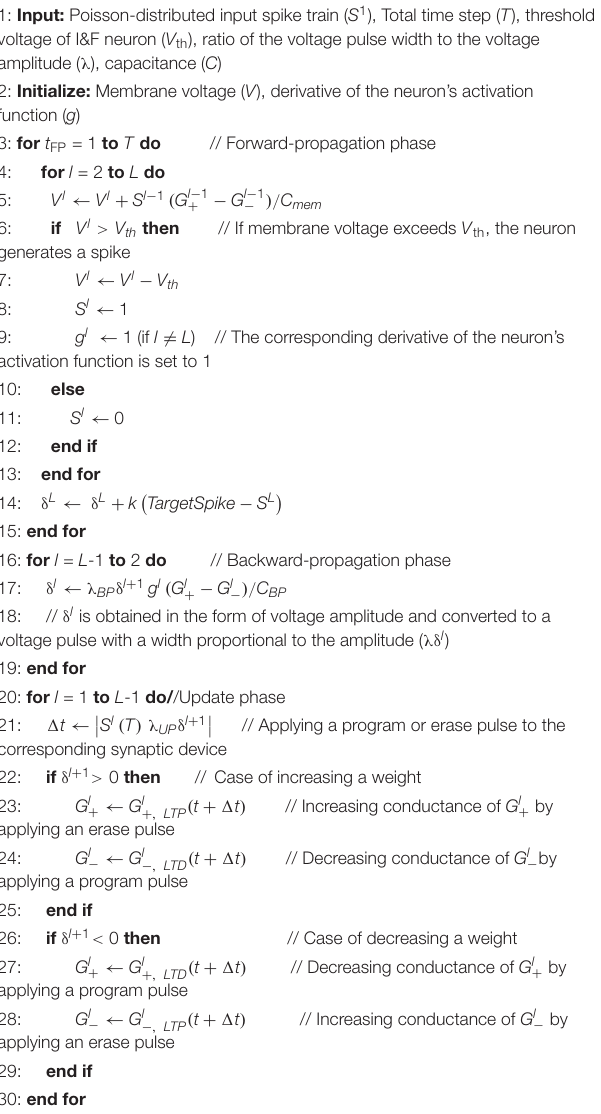
Algorithm 1 | On-chip training scheme in SNNs with synaptic